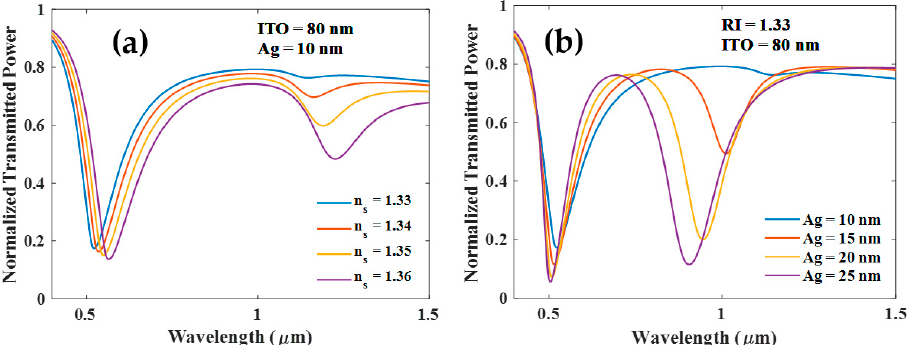
Figure 2. Normalized transmission spectra of sensing probe with ( a ) ITO (80 nm) + Ag (10 nm) and ( b ) for various thicknesses of Ag for 80 nm ITO and analyte RI n s = 1.33.